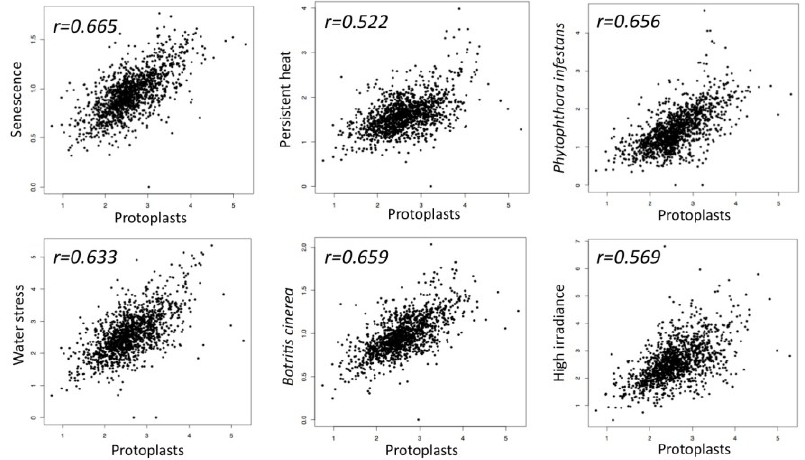
Figure 1. Scatter plots demonstrating similarity in transcription factor expression profiles between dedifferentiating protoplasts and senescing leaves as well as Arabidopsis plants responding to various stress conditions including persistent heat, high irradiance, ozone and pathogen infection. Five hundred seventy-six transcription factor encoding genes differentially expressed in dedifferentiating protoplast cells (GEO GSE15515; fold-change ≥ 2, p value < 0.05) [42,43] were compared to the expression profiles of Arabidopsis senescing leaves (Senescence data were kindly provided by S.H. Wu) [4] as well as to Arabidopsis plants responding to high irradiance (GSE 7743), persistent heat (GSE 18666), water stress (GSE 10670), Phytophthora infestans (ExpressionSet: 1007966021) and to Botrytis cinerea infection (ExpressionSet: